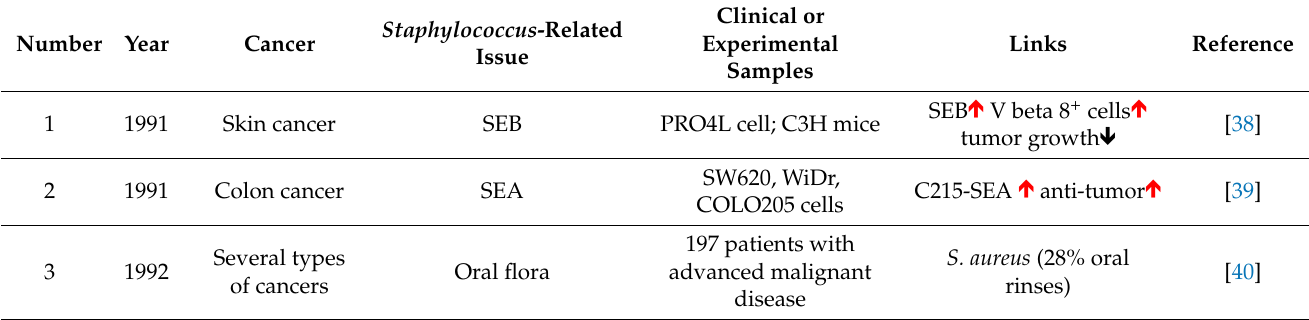
Table 1. Summary of evidence on Staphylococcus and carcinogenesis.